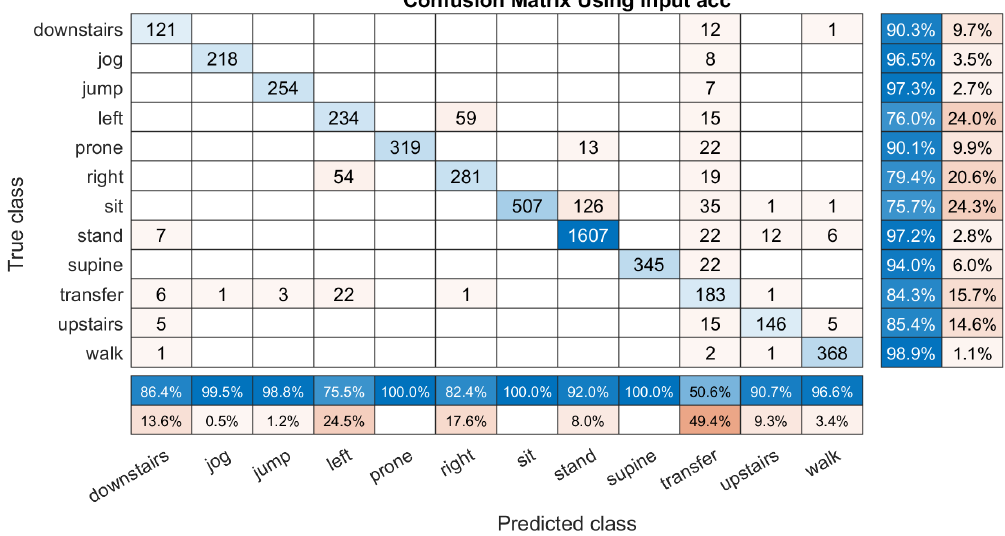
Figure 6. An example of the confusion matrix computed based on the input ’acc’ (˜ s ∗ = s α ). It have a column summary matrix and a row summary matrix to display the accuracy and the errors of each